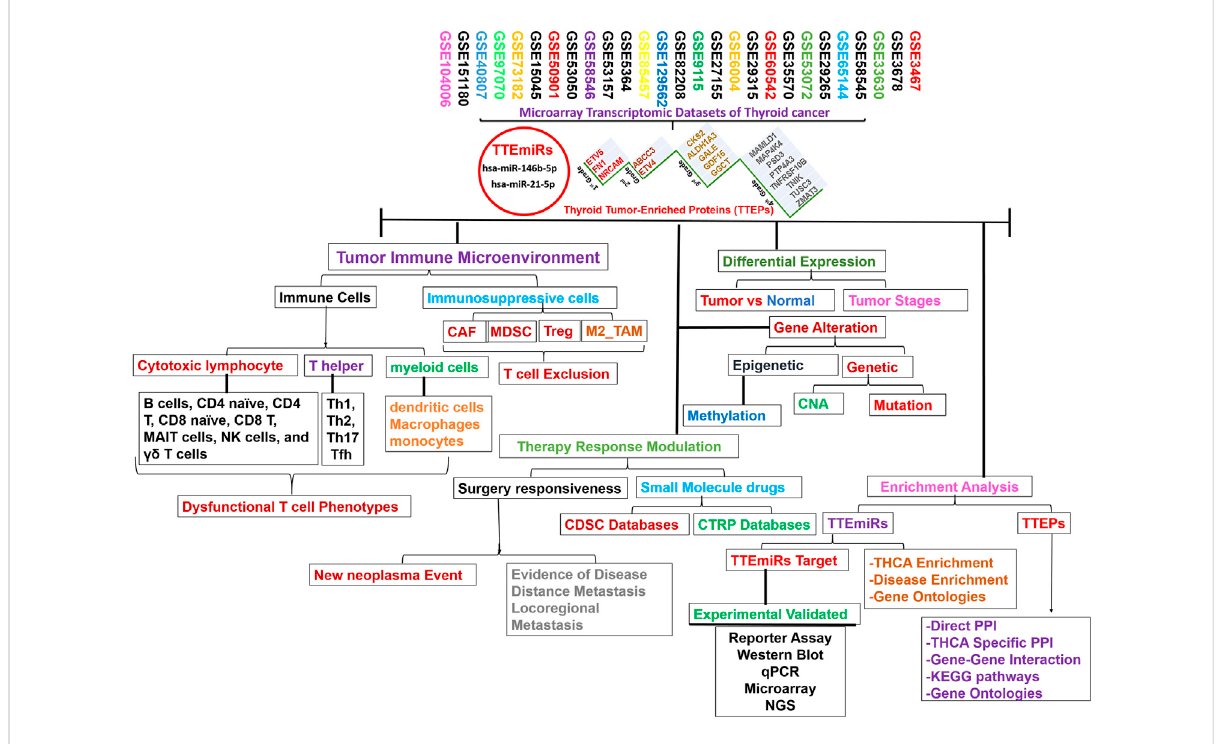
FIGURE 1 Schematic fl ow chart of the study